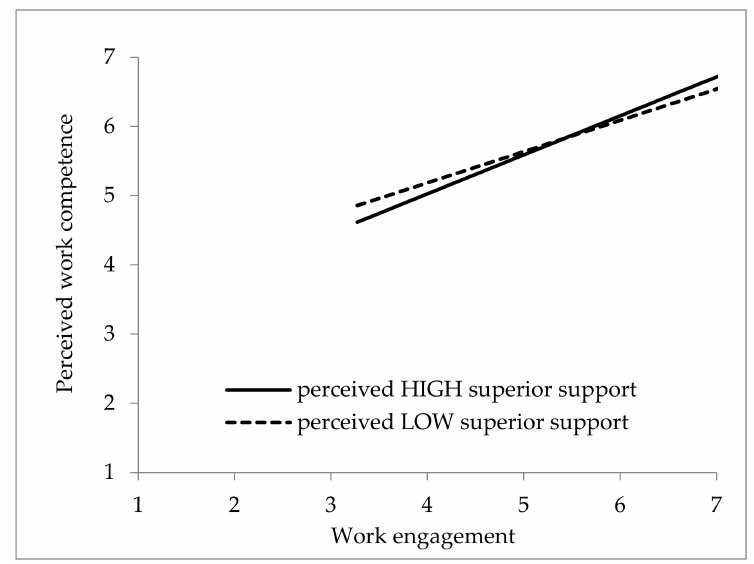
Figure 3. Interaction effect of work engagement and perceived supervisor support on perceived work